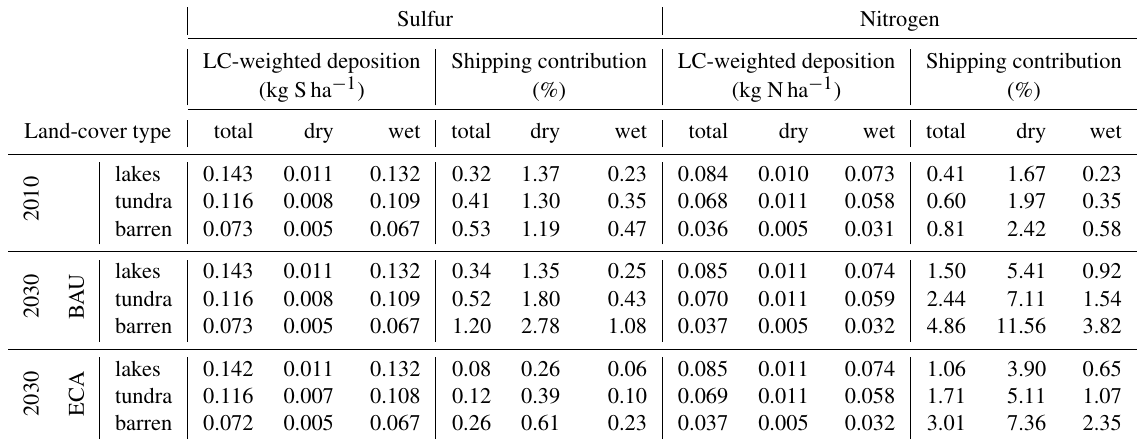
Table 9. Land-cover-weighted deposition of S and N for the eastern Canadian Arctic (60–90 ◦ N, 60–100 ◦ W) over the July–August– September period and corresponding contributions from Arctic